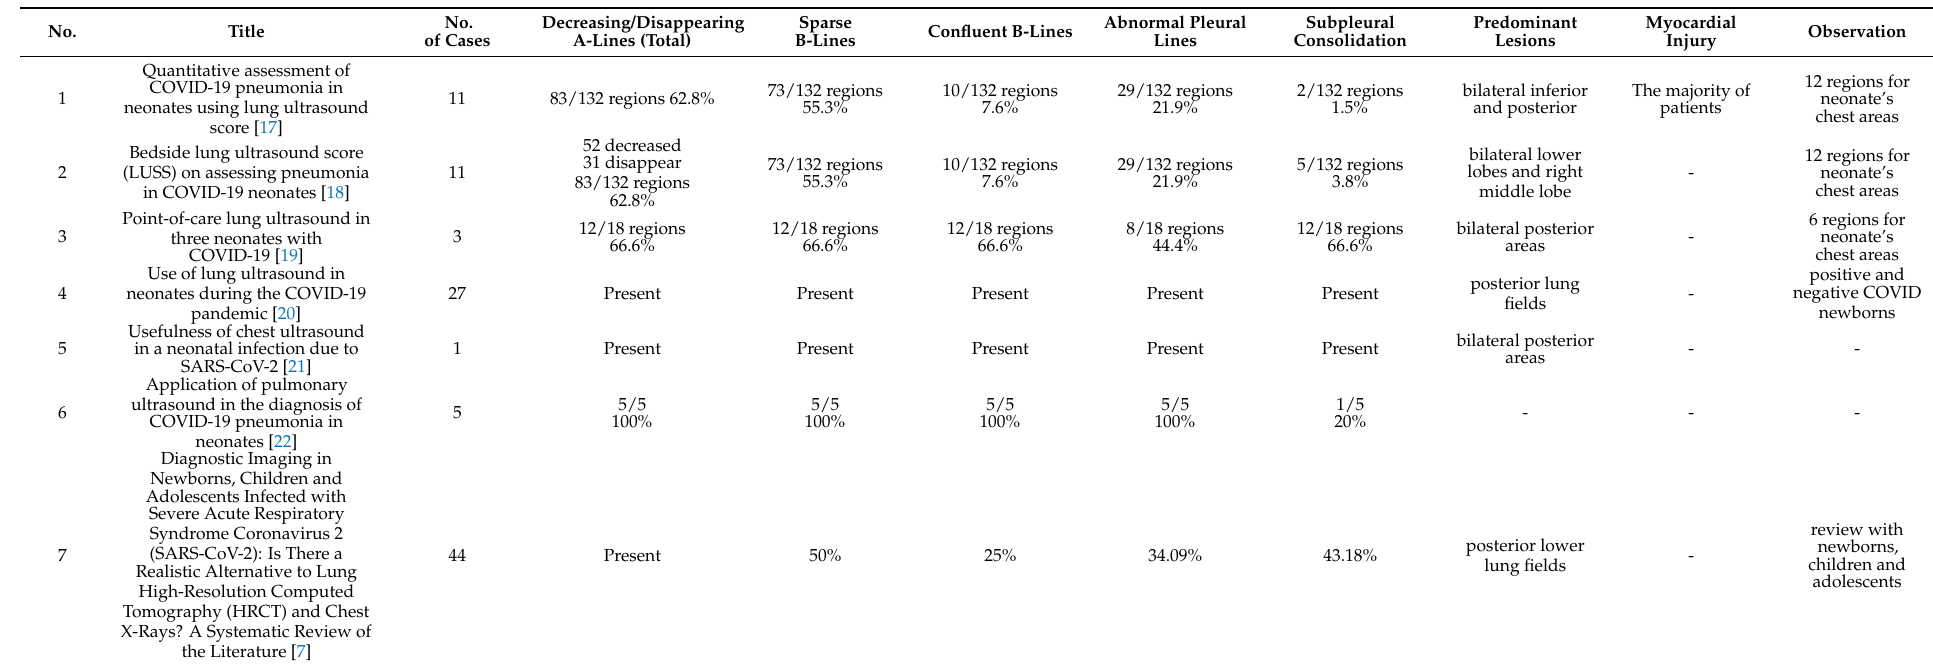
Table 2. Lung ultrasound findings and prevalence of the main changes from included